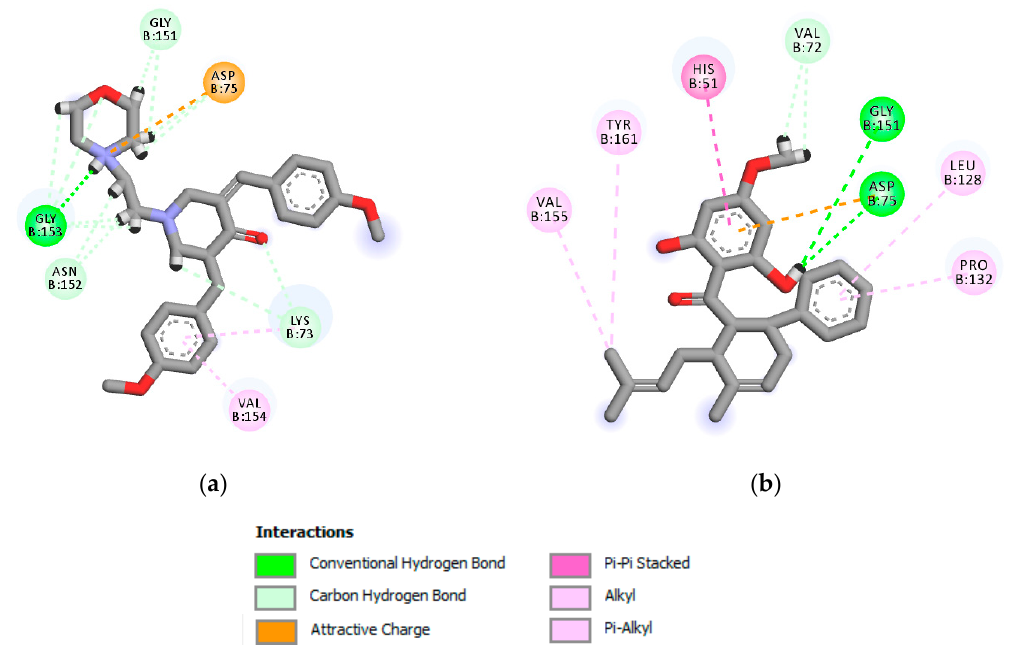
Figure 2. A 2D visualization of ( a ) compound 3 and ( b ) panduratin A in the NS2B / NS3 protease active site.